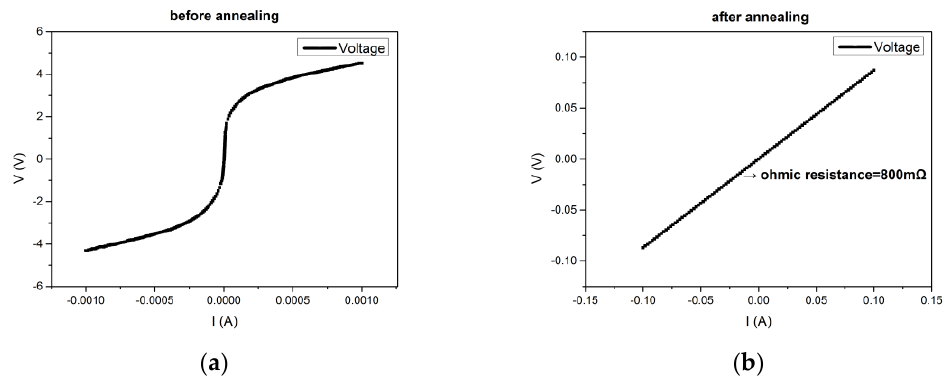
Figure 10. The voltage-current testing results using B1500A ( a ) before annealing, and ( b ) after annealing.